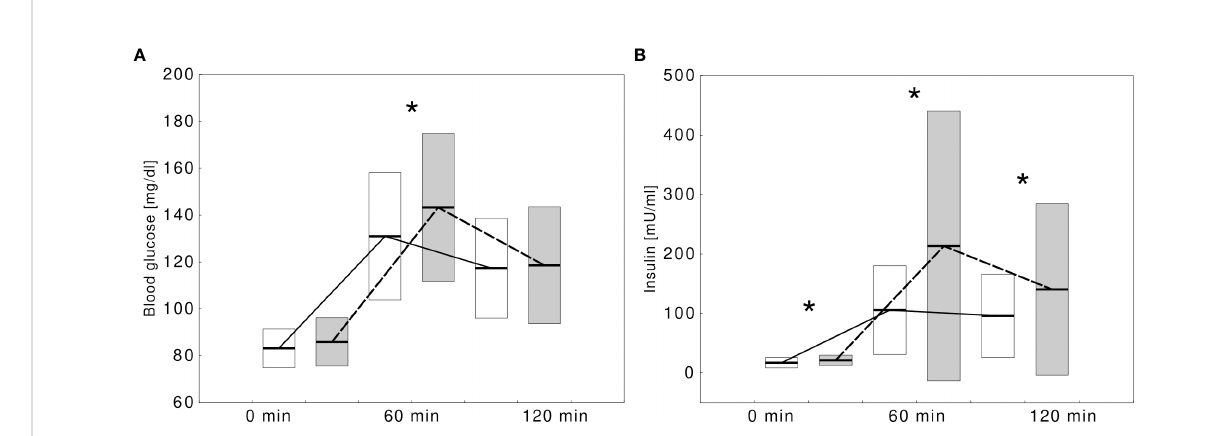
FIGURE 1 Comparison of blood glucose (A) and insulin (B) concentrations during oral glucose tolerance test in obese children without type 1 diabetes- speci fi c autoantibodies (white boxes, solid line) and with at least one autoantibody (gray boxes, dashed lines). Signi fi cant differences (p<0.05) were marked with an asterix